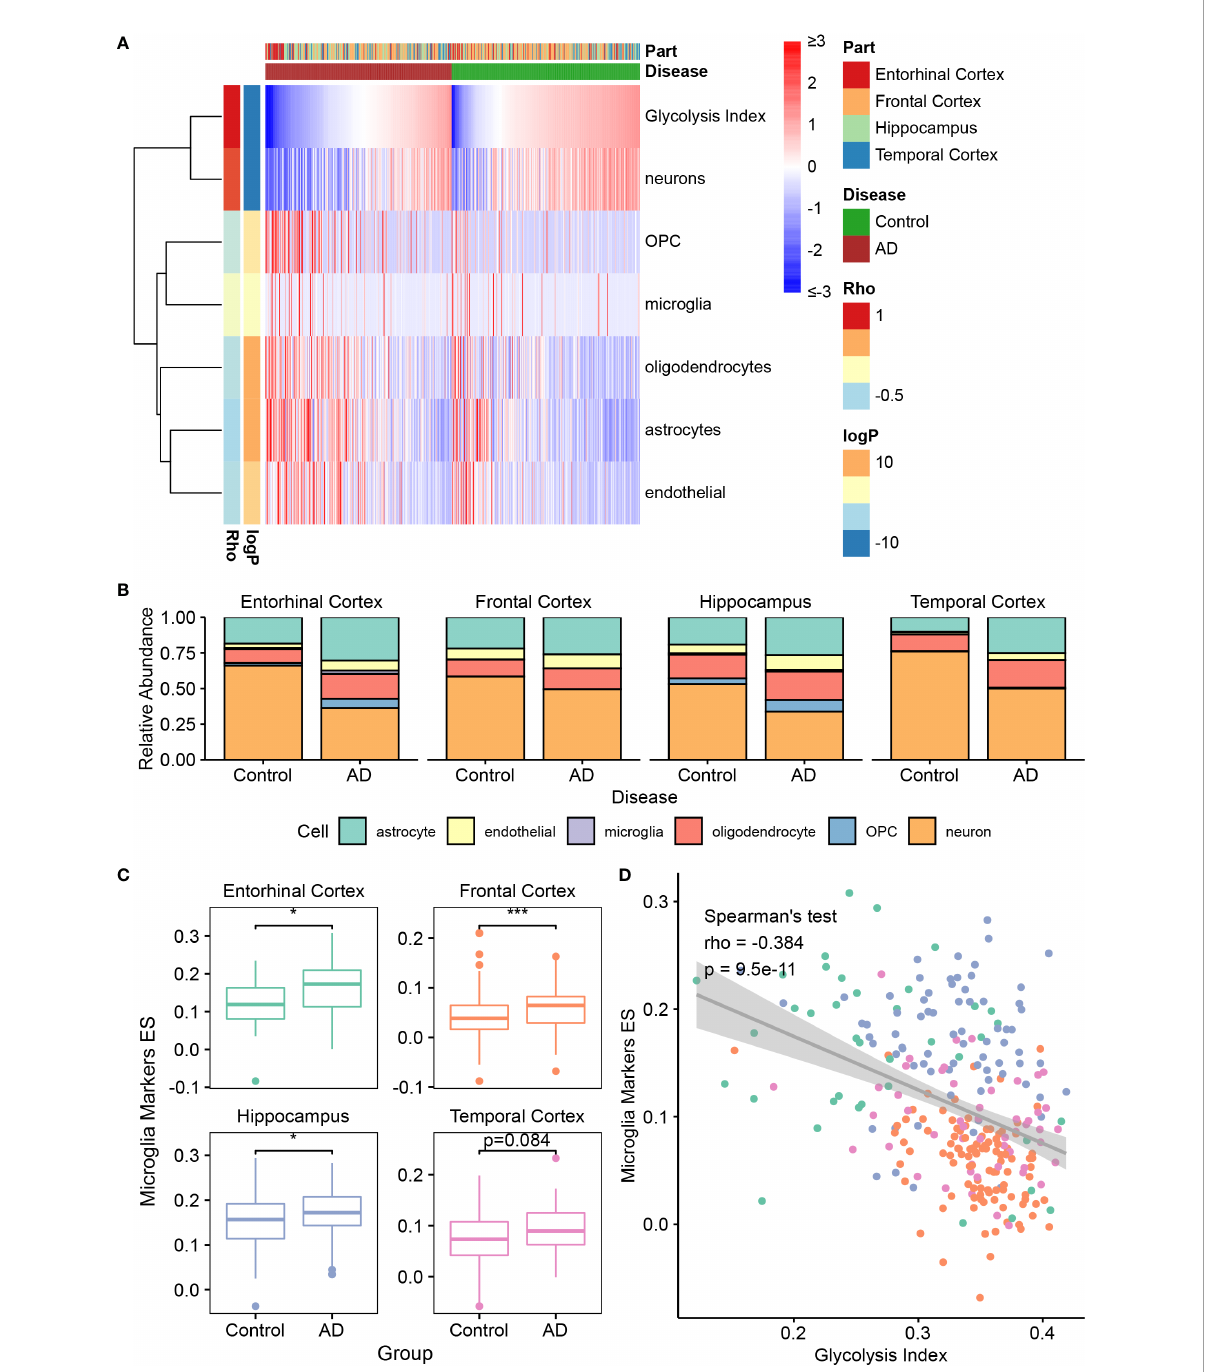
FIGURE 3 The association between glycolysis and the brain microenvironment (A) Heatmap depicts the abundance of six brain cells calculated by CIBERSORTx in AD and control samples. Rho: the Spearman ’ s rho between the abundance and glycolysis index. The signi fi cance of the differences between AD and control are measured by the directed log P values of the Wilcoxon ’ s rank-sum tests. A positive value denotes higher abundance in the AD group. (B) Relative abundance of six brain cell types in different brain regions between control and AD samples. (C) The quanti fi cation of microglia using the ES of microglia marker genes in different brain regions. (D) Spearman ’ s correlation analysis between the glycolysis index and the ES of microglia markers. Different colors indicate different regions, and it is the same as the color in (C) . *p<0.05, ***p<0.001. AD, Alzheimer ’ s disease; ES, enrichment